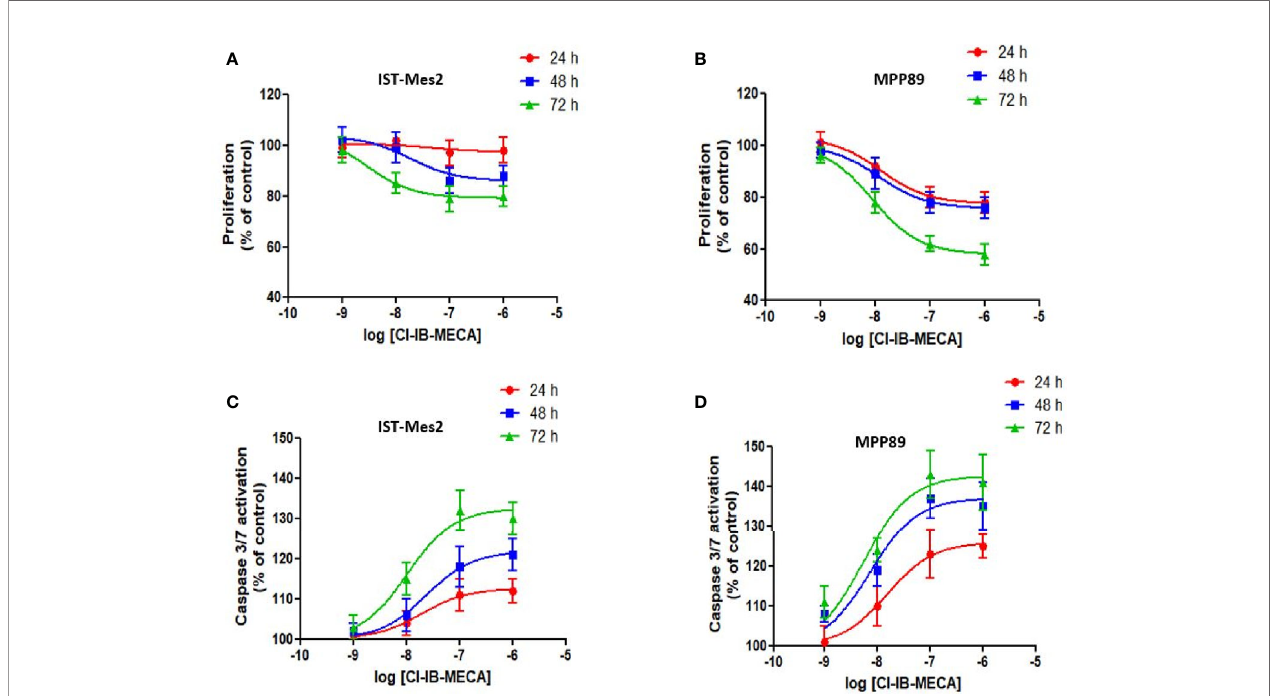
FIGURE 2 | Dose-response assays with Cl-IB-MECA. Effect of Cl-IB-MECA (1 nM – 1 µM) on cell proliferation (A, B) and apoptosis (C, D) in IST-Mes2 (A, C) and MPP89 (B, D) cells. The Caspase 3/7 activation was used as the apoptosis parameter/marker. Results are represented as mean ± standard error of mean (SEM) of n=3 independent experimental